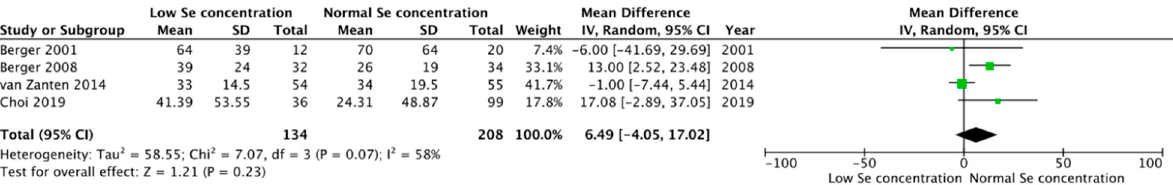
Figure 6. Forest plot of the impact of low serum Se concentration on the length of hospital stay in patients with severe trauma.